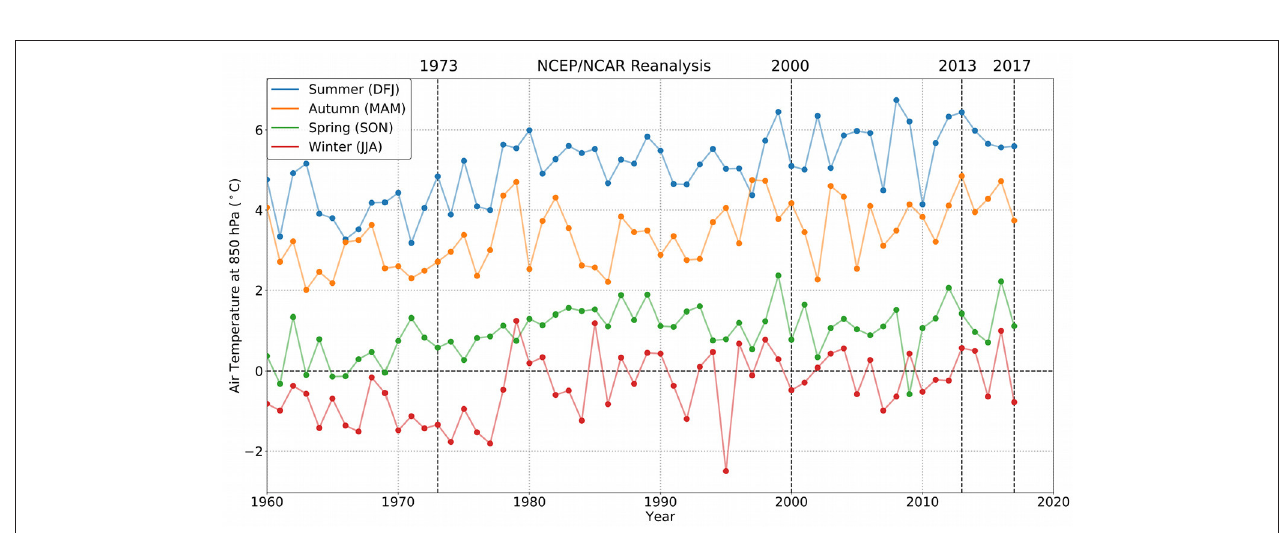
FIGURE 5 | Seasonally averaged air temperatures at 850 hPa between 1960 and 2017 in the Patagonia region (50–40 ◦ S, 280–290 ◦ E) from the NCEP/NCAR Reanalysis product (Kalnay et al., 1996)